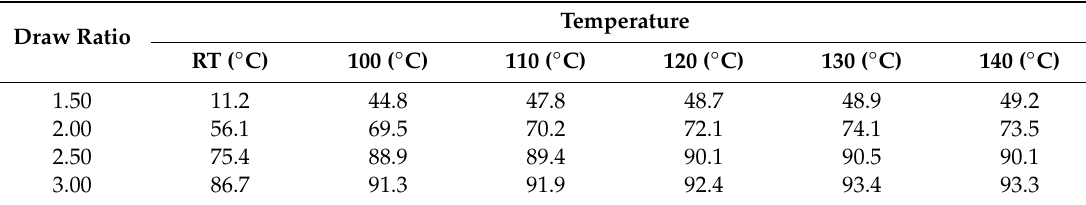
Table 1. The degree of orientation of reflection spot (100) of synchronous thermal stretched γ -PA1010 at di ff erent